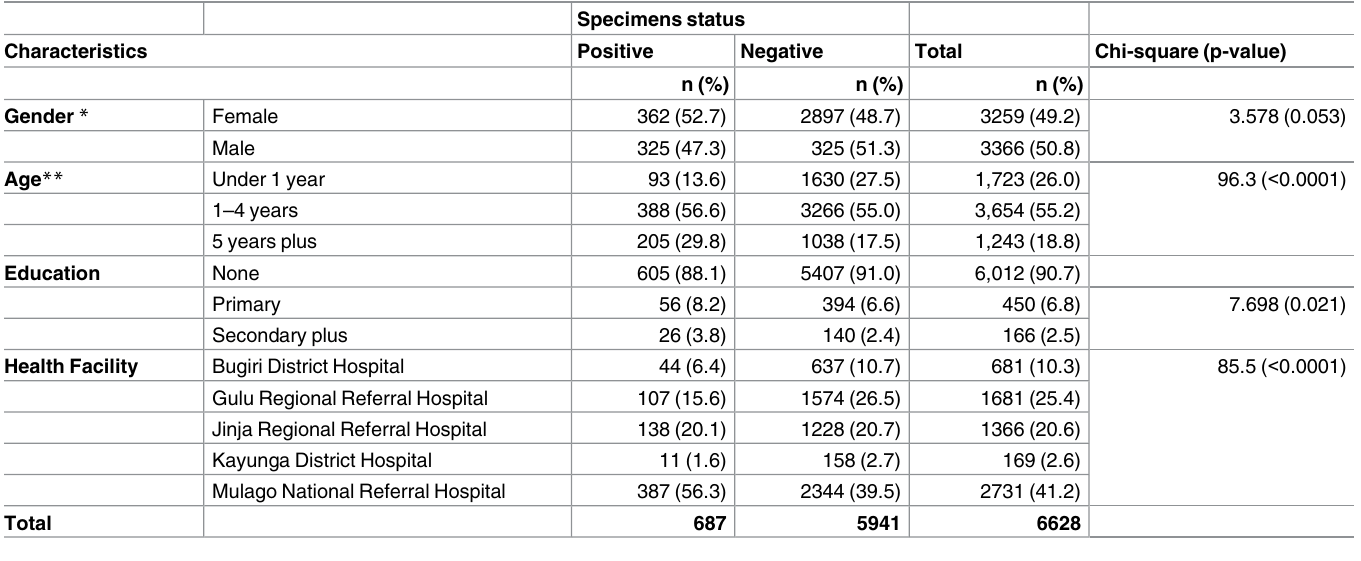
Table 1. Demographic characteristics of patients in the 5 health facilities.